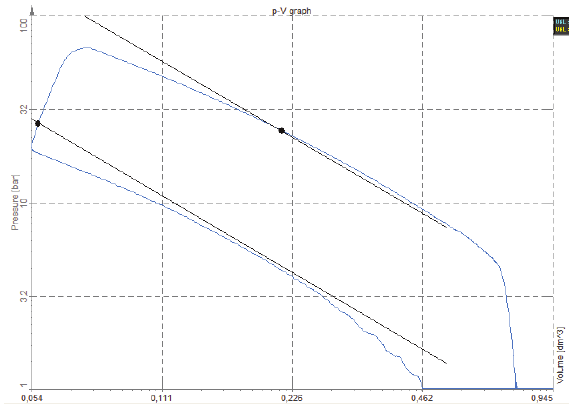
Fig. 12. Preliminary results from PAMAR-4 engine – pressure [Pa] vs volume [dm 3